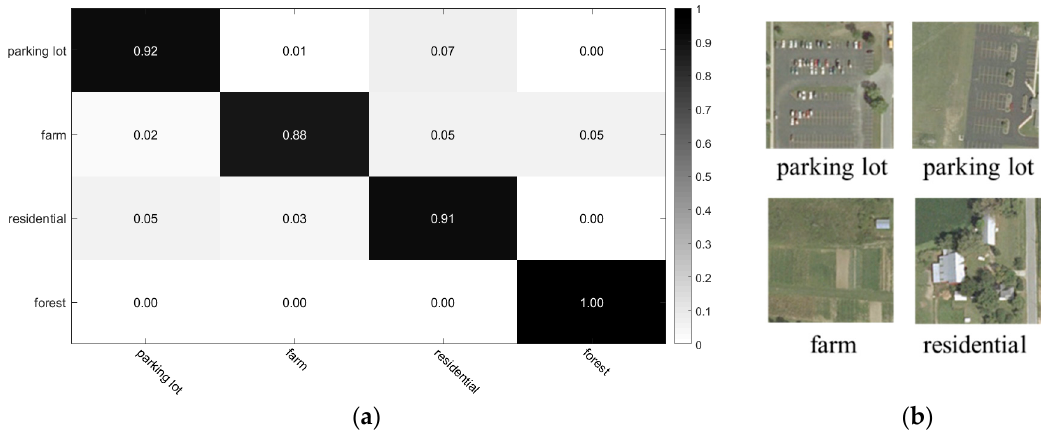
Figure 11. ( a ) The confusion matrix for the USGS dataset based on MOSCRF; ( b ) some of the classification results that MOSCRF (SP) can correctly recognize while frequency vector cannot.